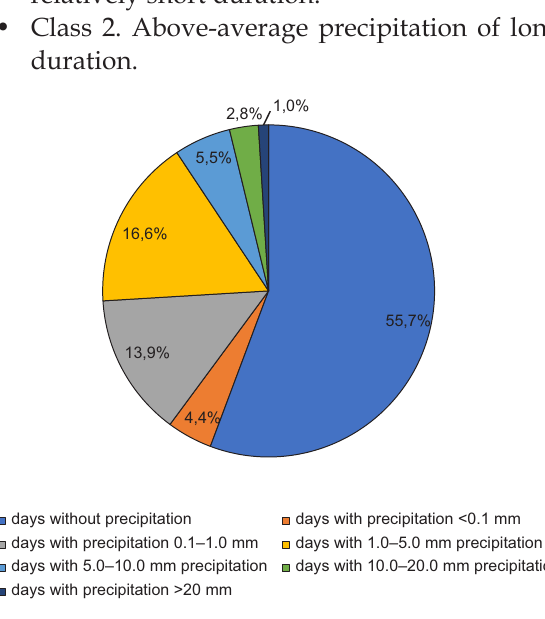
Fig. 5. Distribution of the average number of days with precipitation at various levels in the 1951–2020 period at the iMGW station in